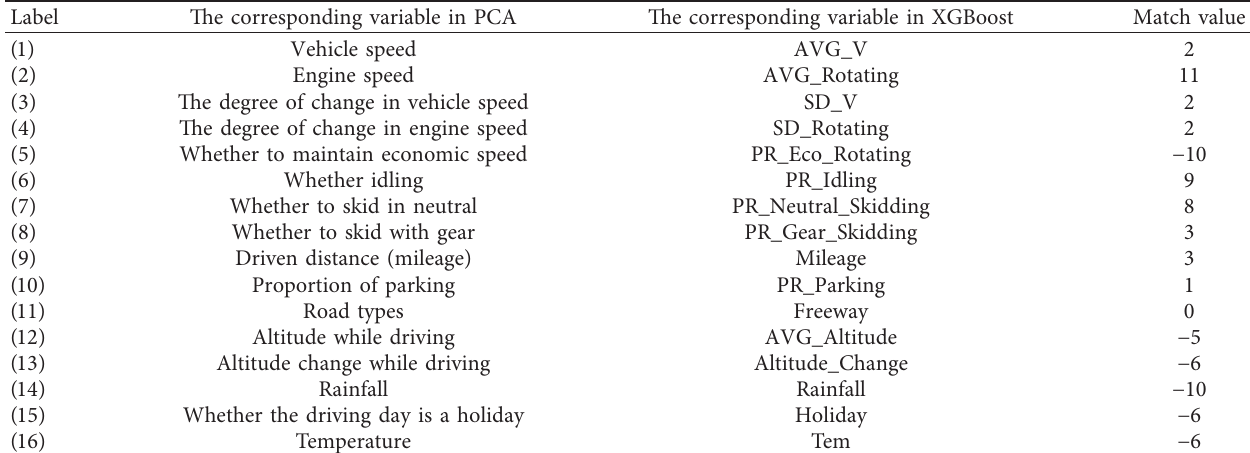
Table 6: Result of indicator